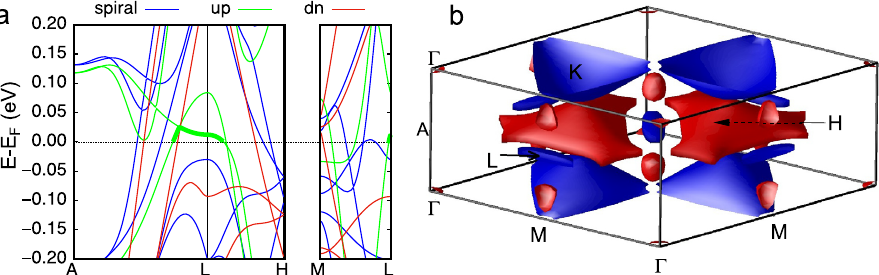
Fig. 4 Electronic band structure and Fermi surface of YMn 6 Sn 6 . a Calculated electronic band structure near the Fermi energy, E F , at the L point of YMn 6 Sn 6 in the magnetic spiral ground state, (blue lines) and in the spin polarized state. The lines with green, and red color represent spin up (up) and spin down (dn) bands, respectively. All calculated bands are shown in Supplementary Fig. 8. b Calculated Fermi surface around Γ , M and